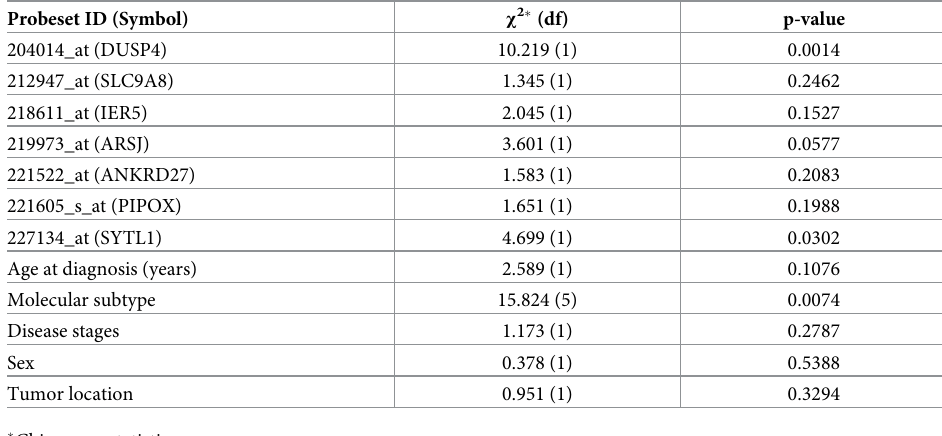
Table 3. Testing the proportional hazard assumption using scaled Schoenfeld residuals.